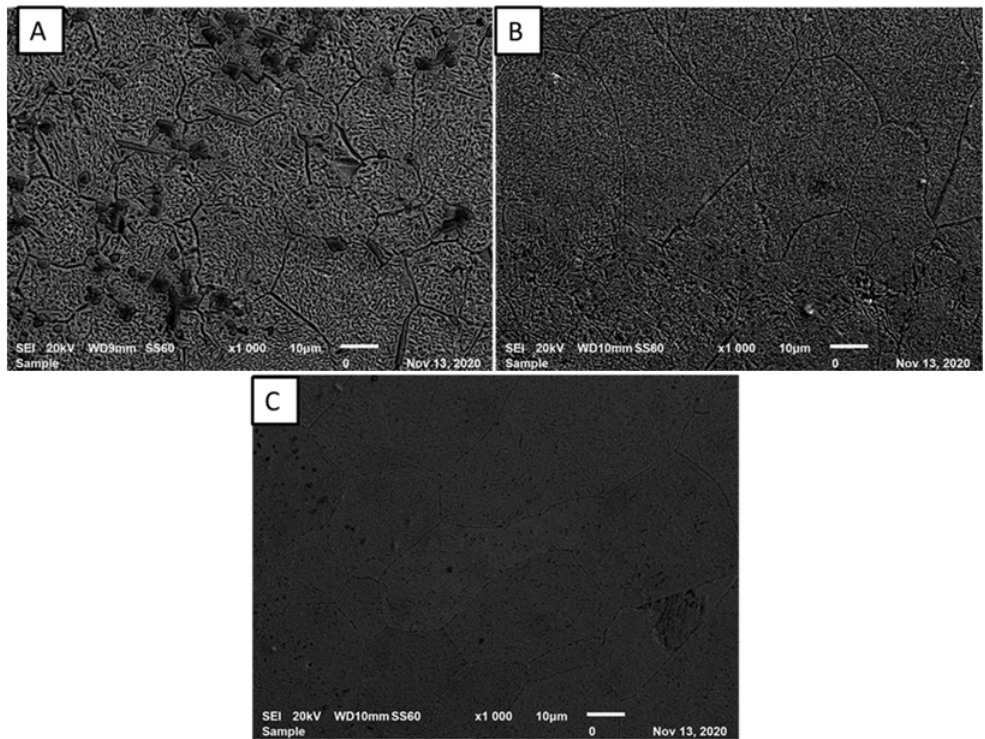
Figure 1. SEM images of Ti-Al-xNb synthesized at different Nb feed rate ( A ) A; ( B ) A1; ( C ) A3 and 1L/min Nb gas carrier.